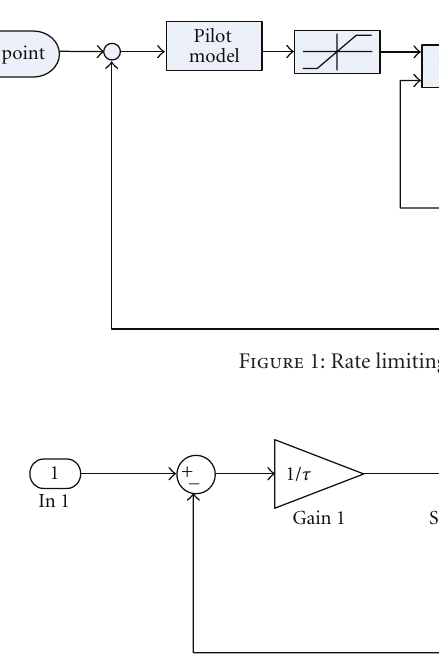
Figure 2: Rate limit actuator dynamic